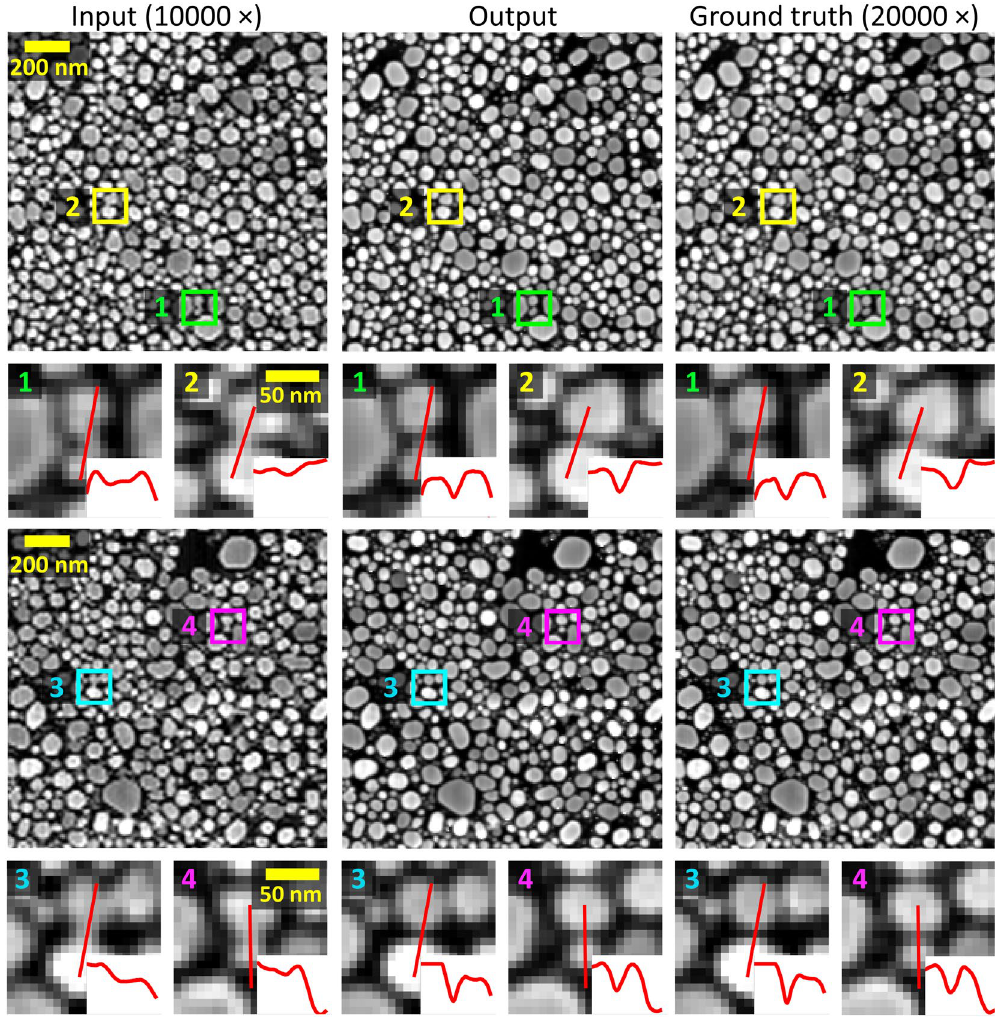
Figure 2. Examples of the up-sampled network input images compared to the output and ground truth SEM images. Cross sections of various spatial features with noticeable resolution enhancement are